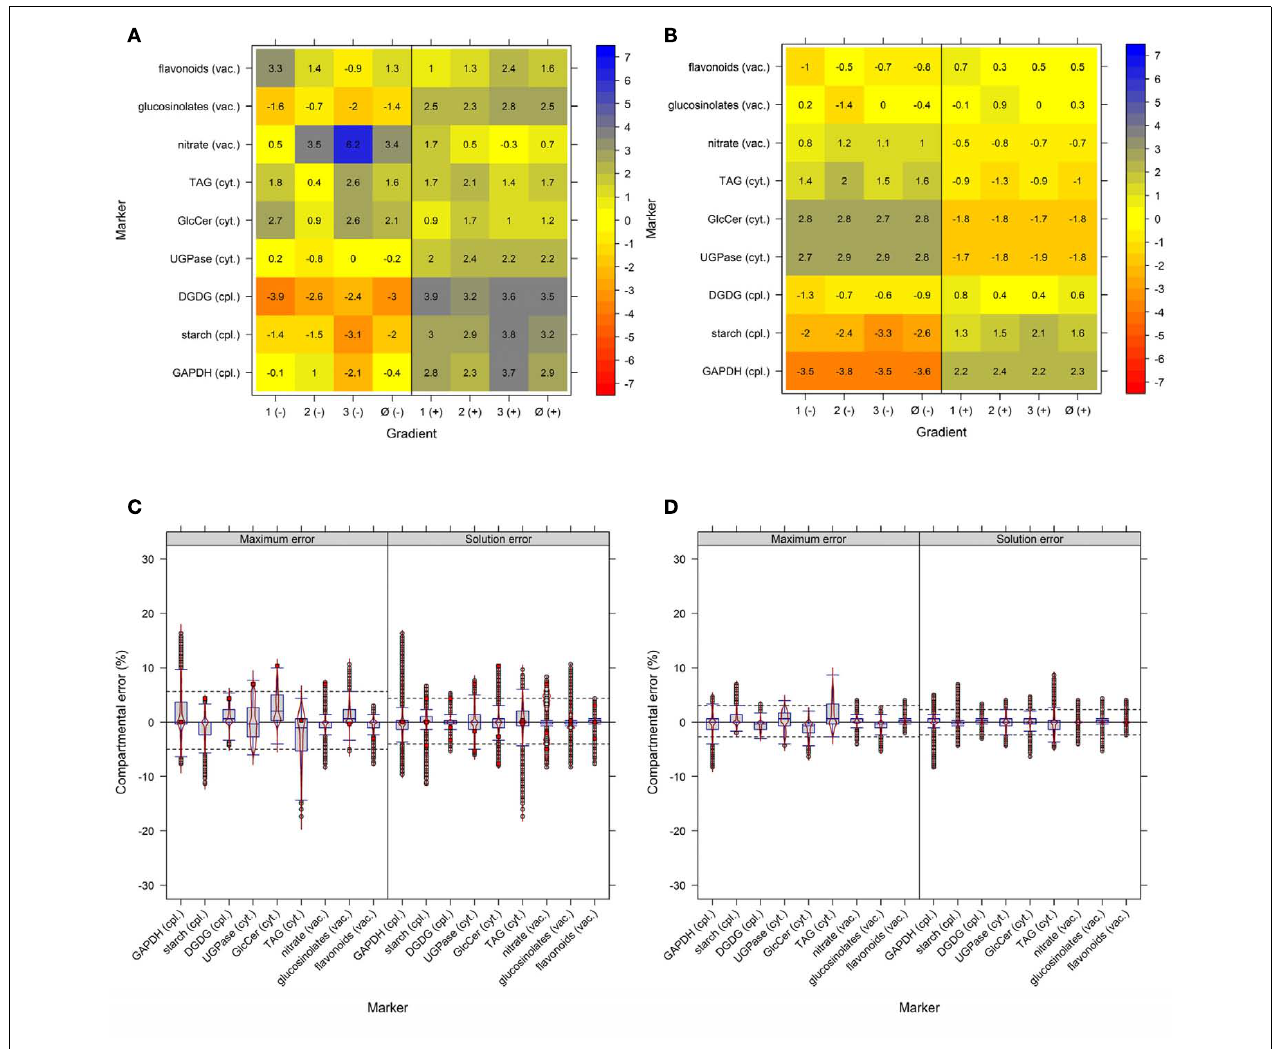
Combined box- and violin plots (red lines) showing the difference of the maximum and solution error based on compartmental abundances estimated using BFA when (C) deleting one marker or (D) considering one marker twice. All estimates are based on the difference observed after mean–average of the three independent gradients. Red squares in (C) depict the difference in the marker that was deleted.The 5th and 95th percentiles are drawn as black dashed lines. For both, positive values indicate larger compartmental abundances when all nine markers were used while negative values depict larger abundances when a marker was deleted or considered